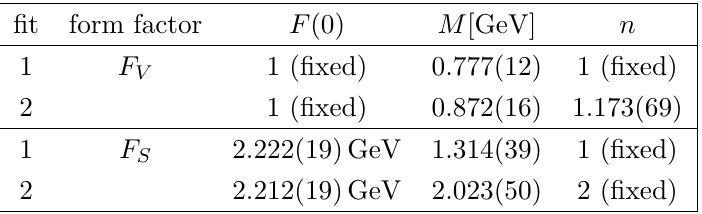
Table 4. Parameters obtained in (cid:12)ts of our form factor data to